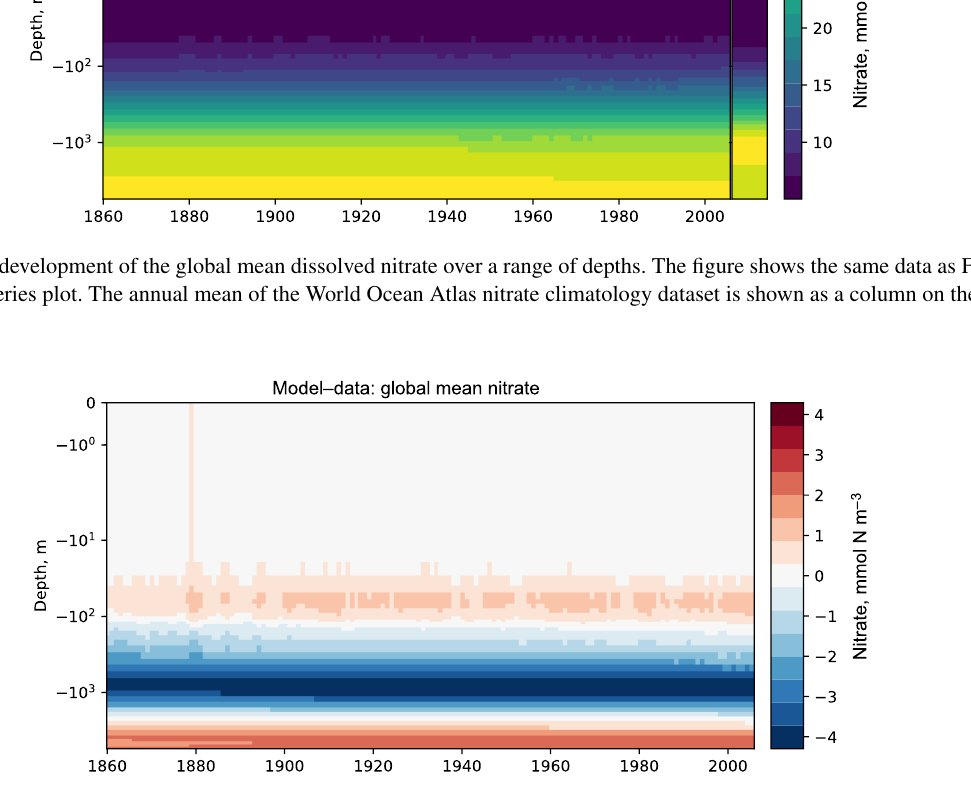
Figure 8. The time development of the global mean dissolved nitrate over a range of depths. The figure shows the same data as Figs. 6 and 7, but with the World Ocean Atlas nitrate observational measurement subtracted from the model time